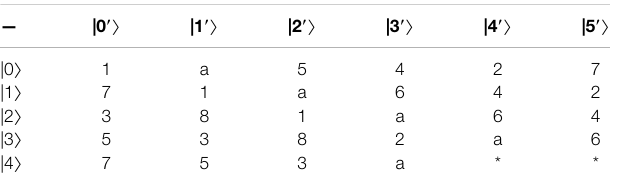
TABLE 3 | 8×3+1×4=28-member.